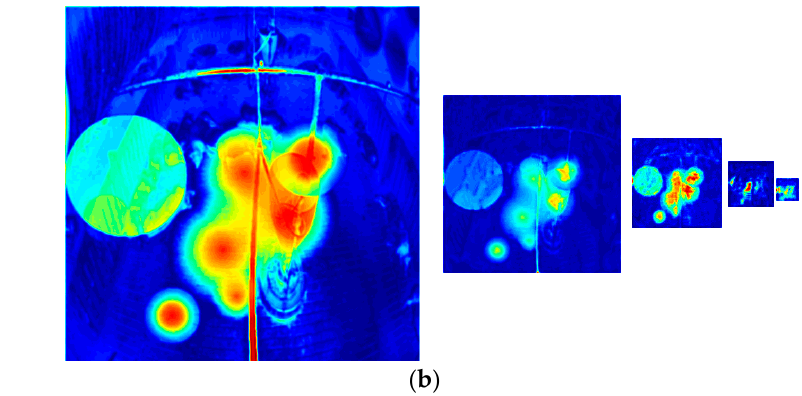
Figure 11. Denoised image produced by the model with and without the attention model on real ‐ noise image: ( a ) real ‐ noise image; ( b ) denoised image without attention module; ( c ) denoised image with attention module.